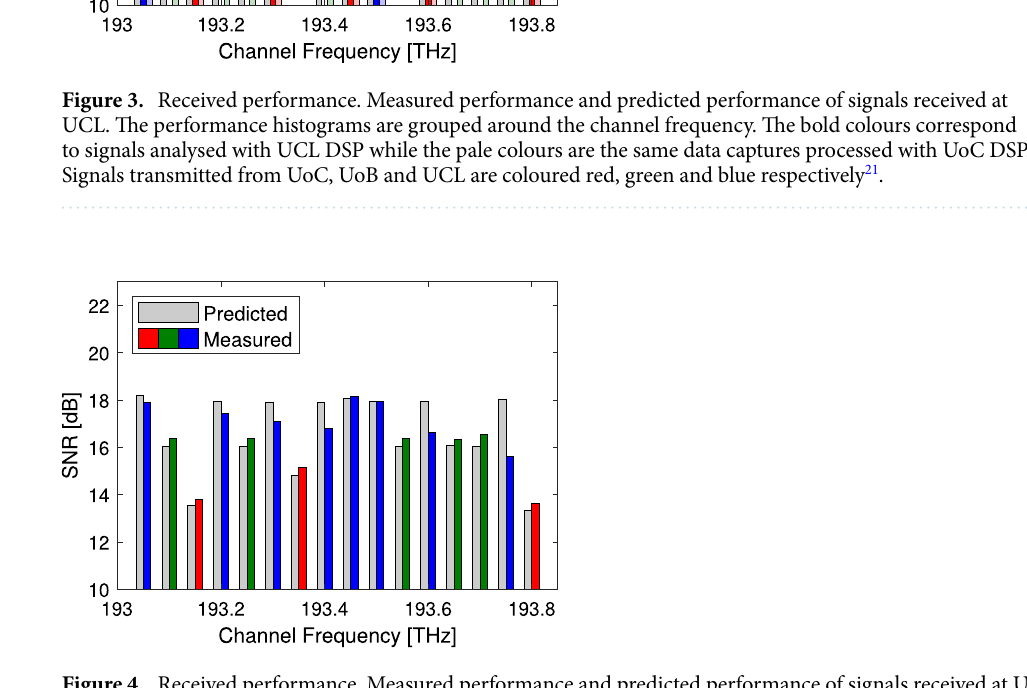
Figure 4. Received performance. Measured performance and predicted performance of signals received at UoC with UoC DSP. The performance histograms are grouped around the channel frequency. Signals transmitted from UoC, UoB and UCL are coloured red, green and blue respectively 21